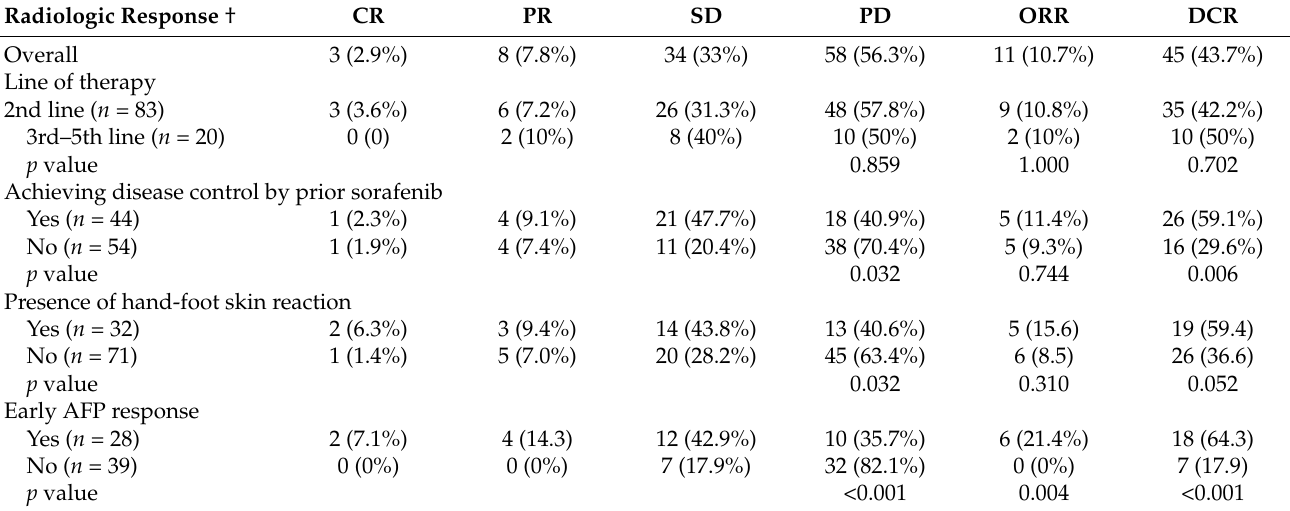
Table 2. Best radiologic responses to regorafenib therapy by RECIST v1.1 criteria.